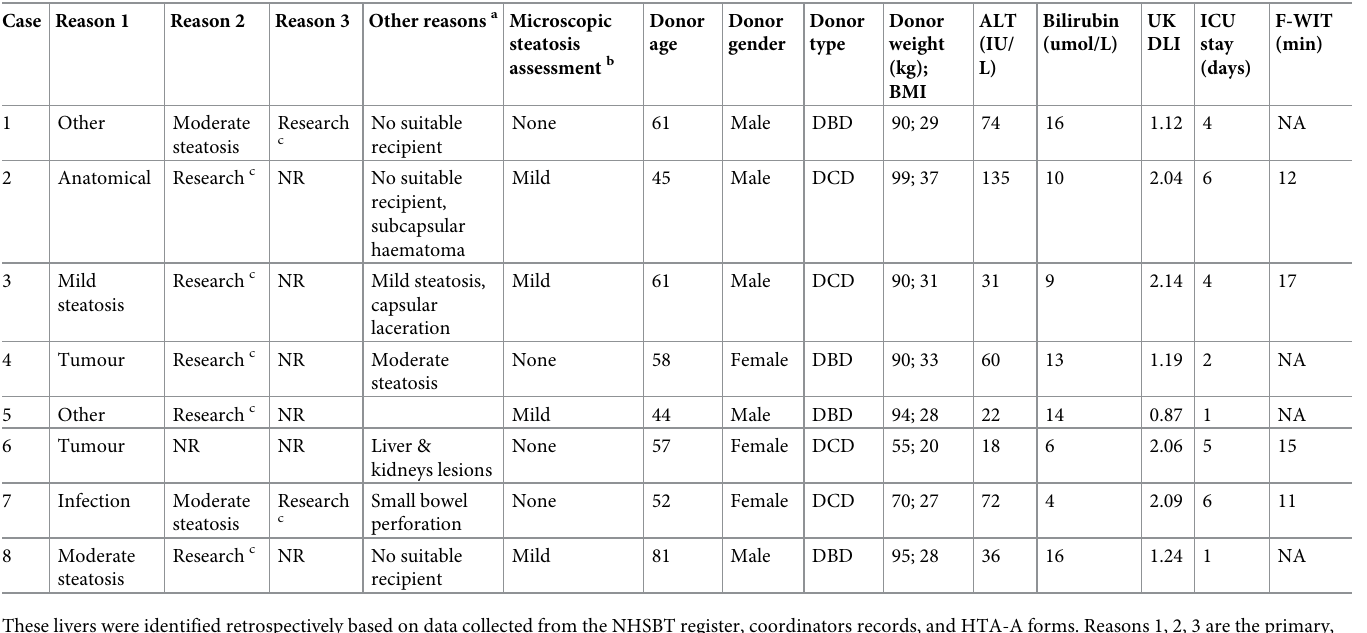
Table 3. Reasons of graft decline for transplantation and characteristics of low-risk